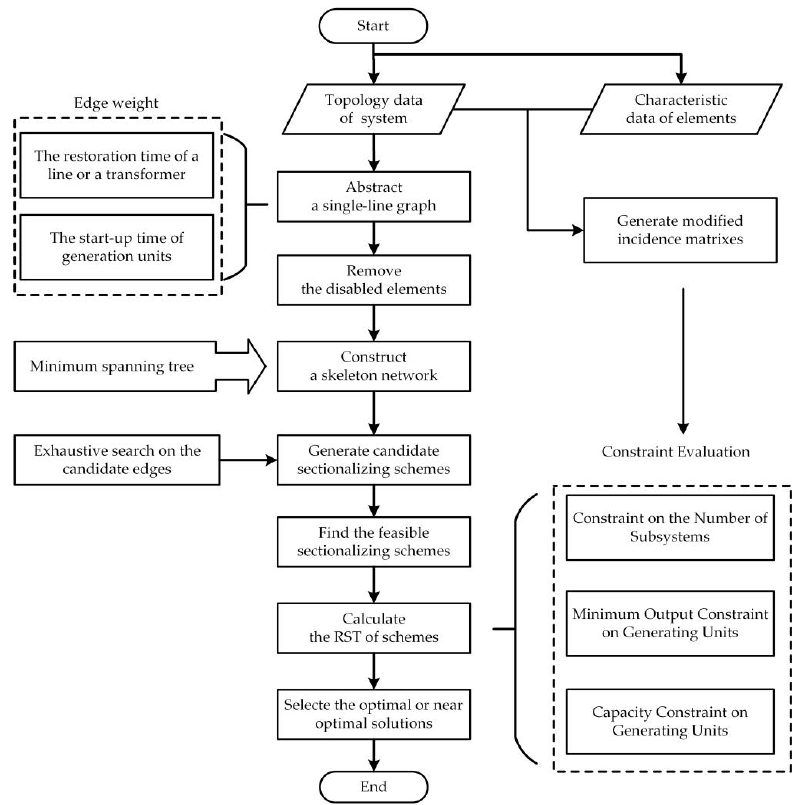
Figure 1. The flow diagram of the proposed method.